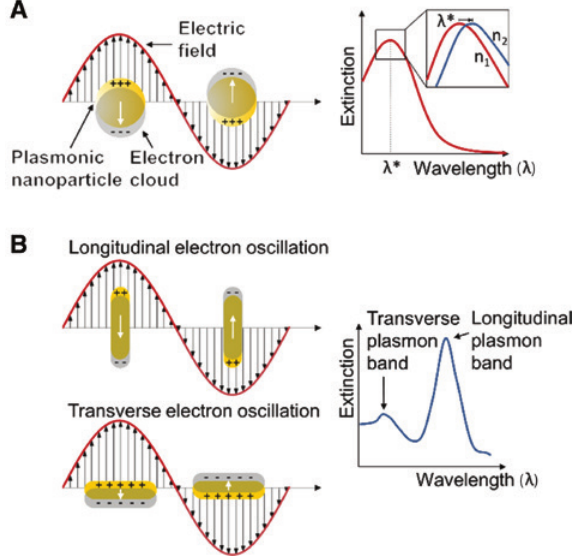
Figure 1: LSPR excitation and extinction spectra for plasmonic (A) nanoparticles and (B) nanorods. LSPR sensors detect shifts in the resonance wavelength λ * , shown in the extinction spectra of (A), in response to alterations in the refractive index of the medium containing the plasmonic nanoparti- cle. The nanorods of (B) show longitudinal and transverse plasmon bands corresponding to the electron oscillations along the long and short axes, respectively. Adapted and modified from [10,